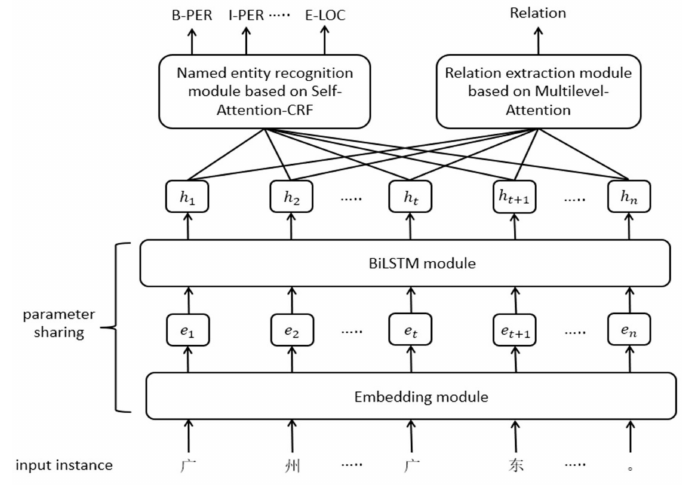
Figure 4. The framework of joint learning model based on self-attention.